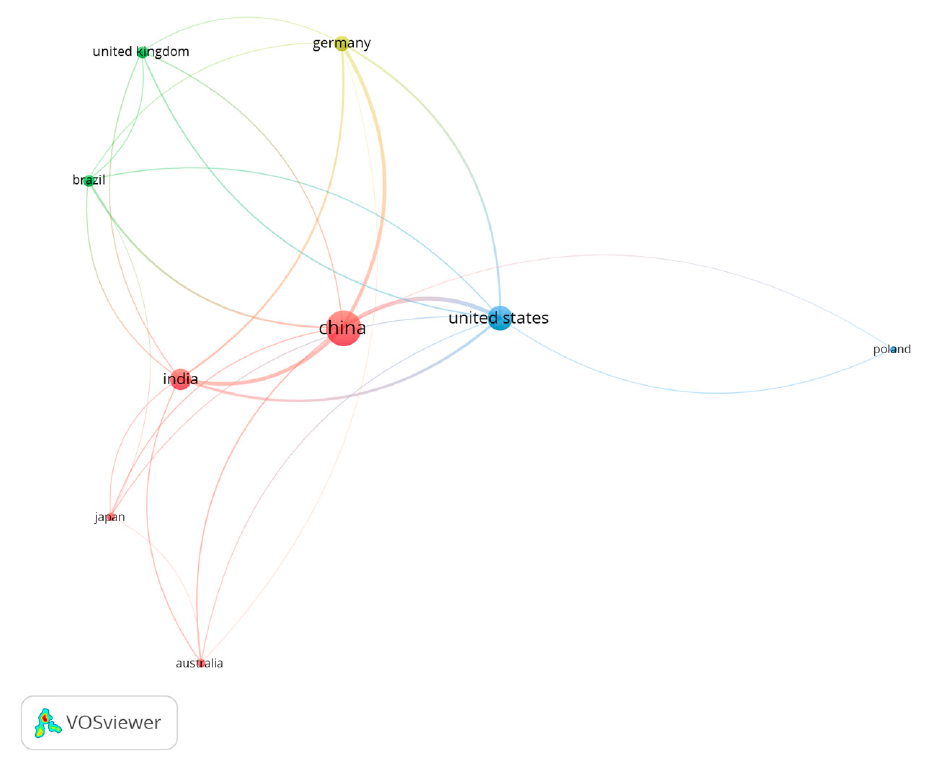
Figure 12. Co-citations of the regions/countries.